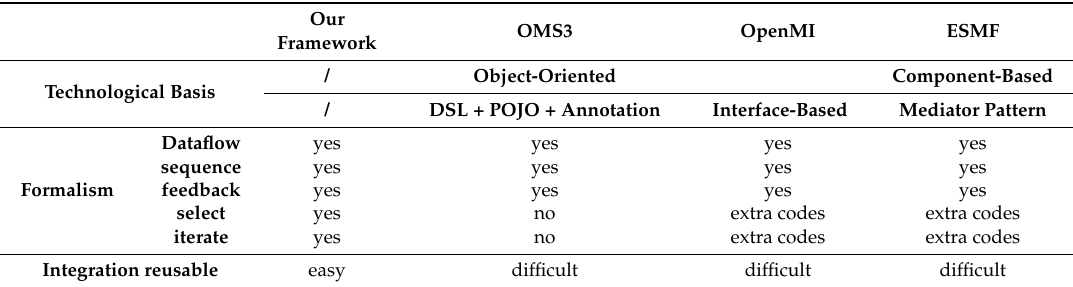
Table 1. The comparison with other